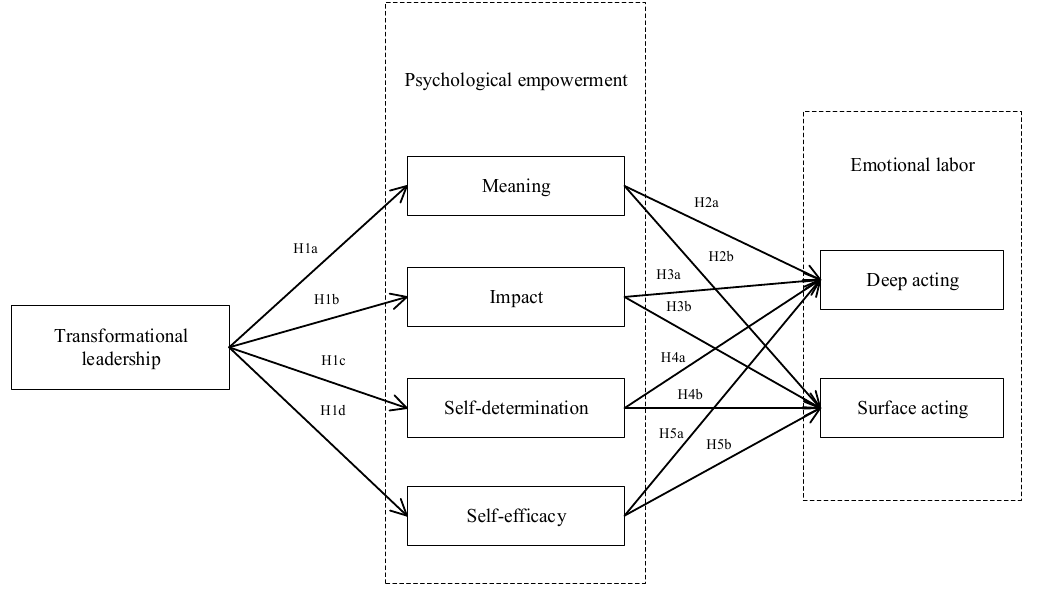
Figure 1. The c onceptual model. Figure 1. The conceptual